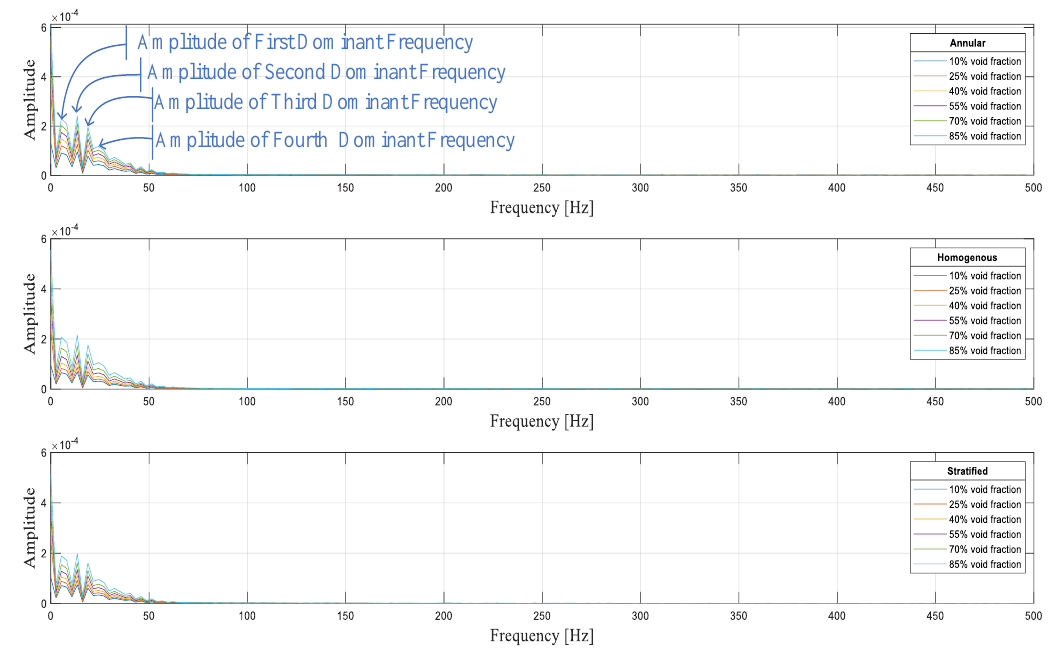
Figure 6. Converted signals into the frequency domain for a scale thickness of 1